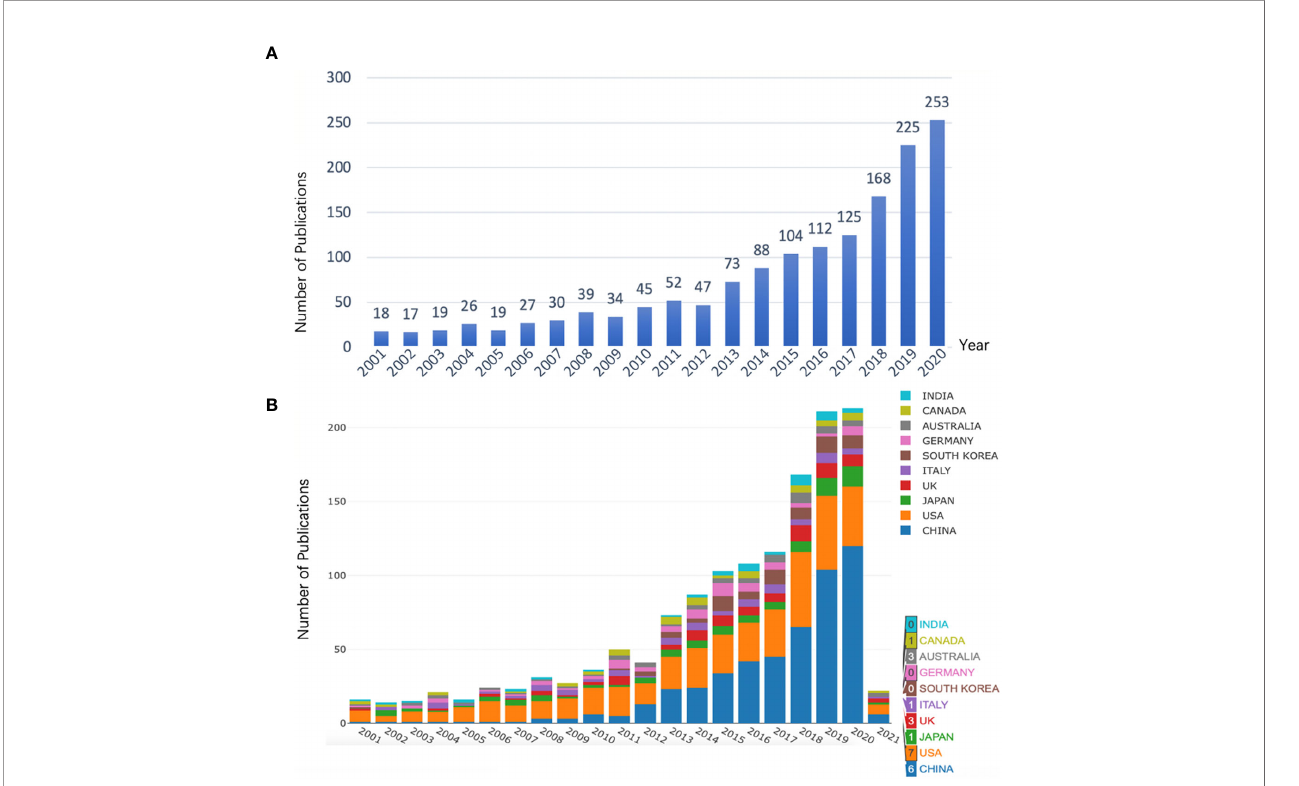
FIGURE 1 | (A) Number of annual research publications and growth trends on the topic of anesthesia and tumor prognosis from 2001 to 2020, export of results from Web of Sciences (https://wcs.webofknowledge.com). (B) Number of annual publications and growth trends of the top 10 countries/regions on research in anesthesia and tumor prognosis from 2001 to 2021, export of results from the Online Analysis Platform of Literature Metrology (http://biblimetric.com). Bar chart re fl ects number of online articles online per